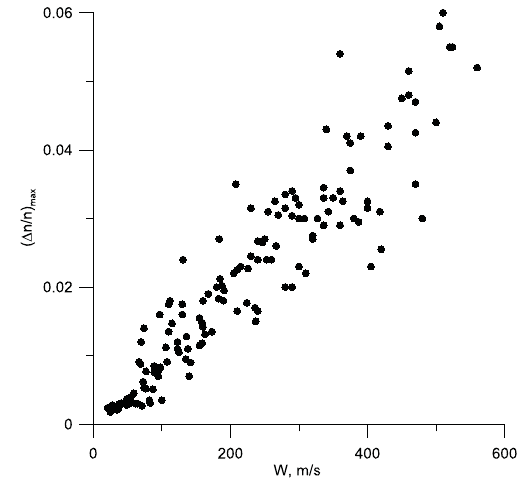
Figure 7. The dependence of AGW amplitude on the wind